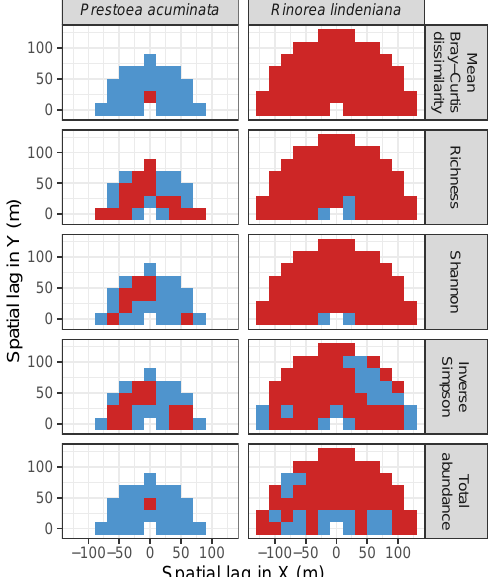
Figure A9. Codispersion between measures of diversity and total basal area of the focal understory species in 20 20-m subplots in the 16-ha Luquillo ( Prestoea acuminata ) and 25-ha Amacayacu ( Rinorea × lindeniana ) plots. Codispersion coefficients were calculated for spatial lags ranging from 0–80 m (LFDP) and 0–125 (AM) at 20-m intervals. The value of the codispersion coefficient can range from blue) through 0 (white) to 1 (dark red). Statistical significance of each codispersion coefficient is shown in Figures A10 and A11.